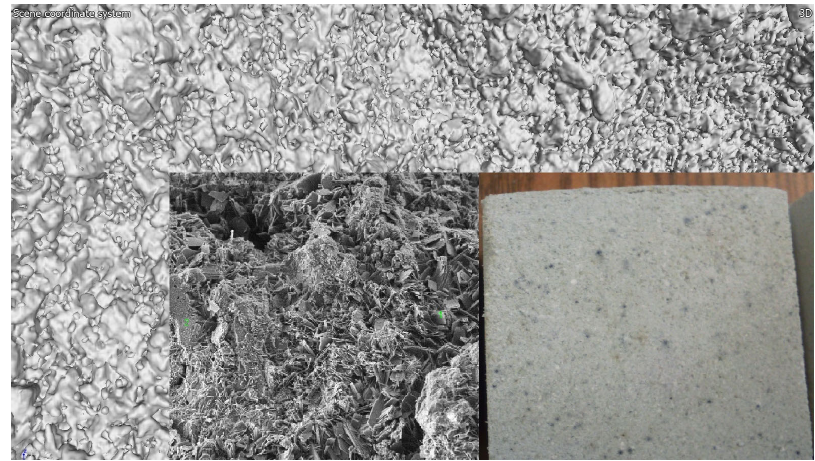
Figure 17. Computer tomography with a photograph of the analyzed laboratory brick and an area